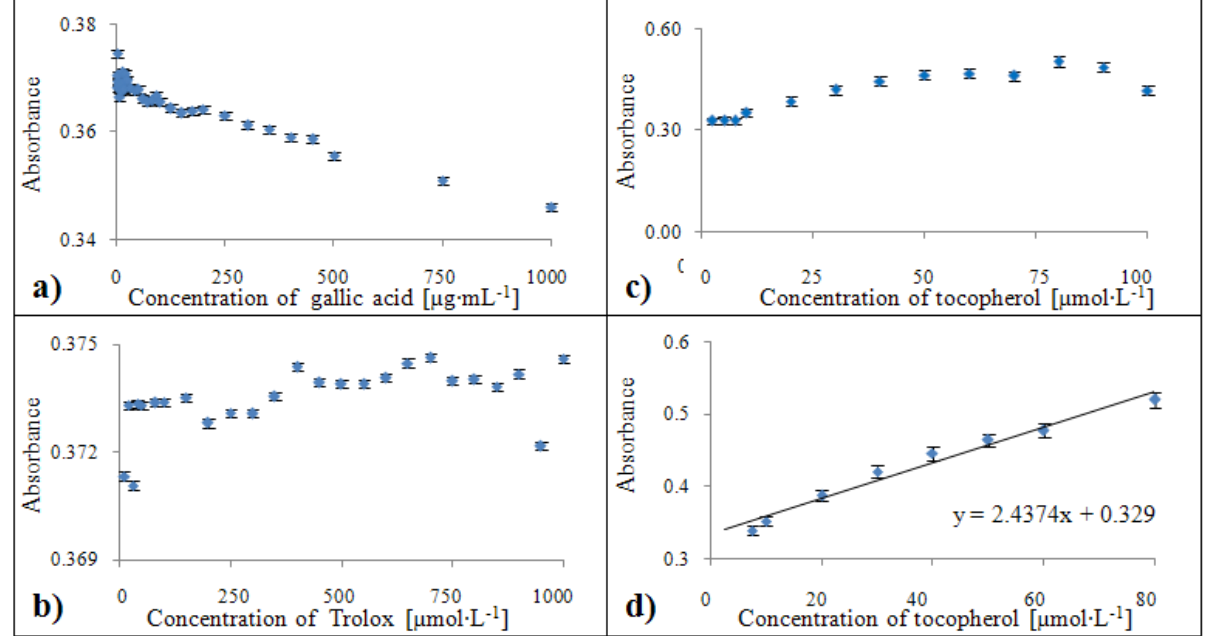
Figure 12. Dependences of absorbance of colour product on concentration of gallic acid (a) , trolox (b) and tocopherol (c) . Calibration curves for Blue CrO equivalent of tocopherol (d) expressed in units of